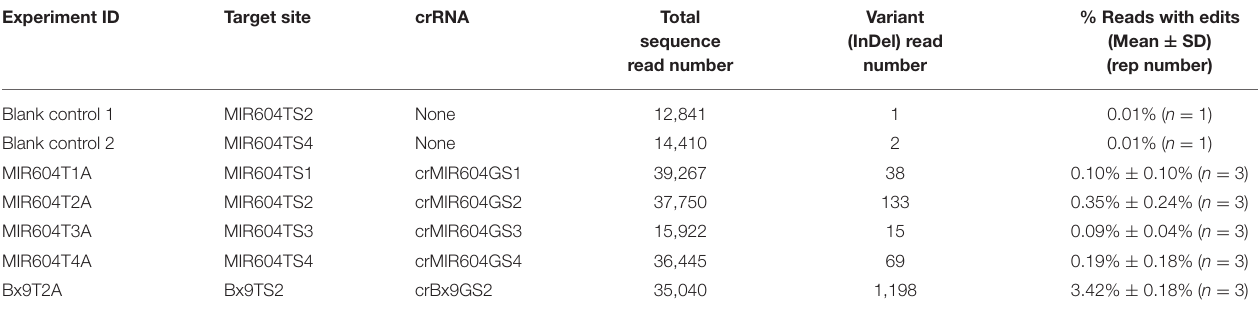
TABLE 1 | Transient editing of maize chromosomal target sequence by AsCas12a-Ultra RNP complexes delivered via particle bombardment of immature embryos. Experiment